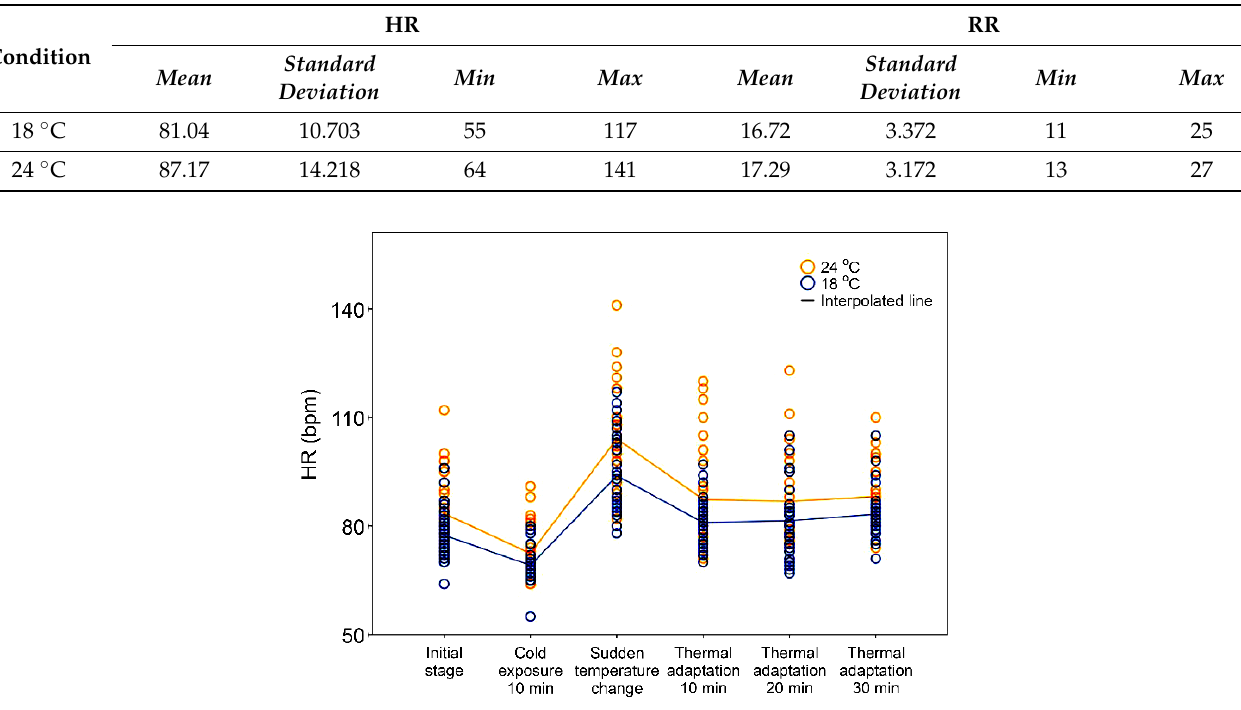
Table 6. Statistics of HR and RR.